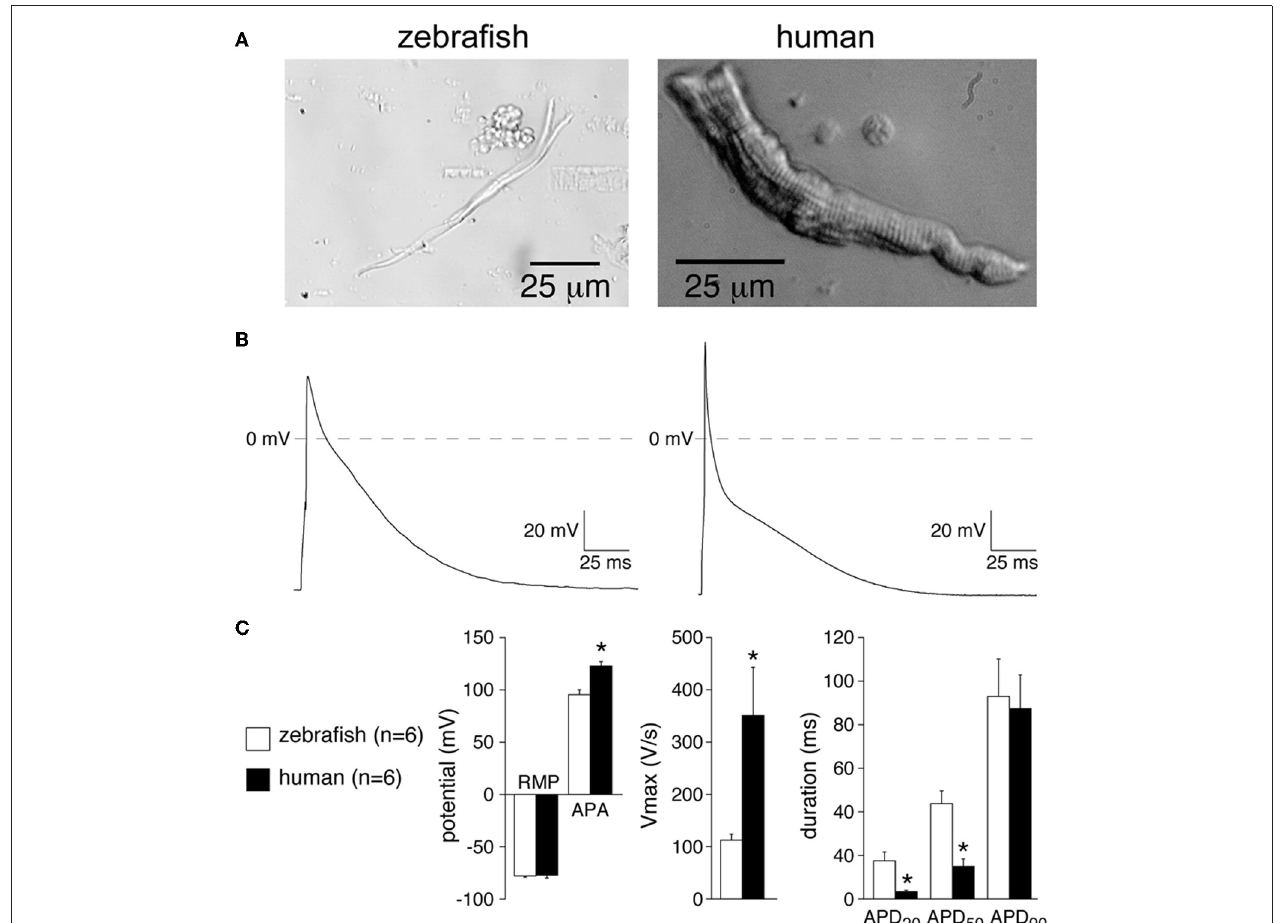
(zebrafish) and Verkerk et al., 2007 (human) for solutions used]. (C) Average AP characteristics of zebrafish and human atrial myocyte recorded at 1Hz. RMP, resting membrane potential; APA, AP amplitude; Vmax, maximal AP upstroke velocity; APD 20 , APD 50 , and APD 90 , AP duration at 20, 50, and 90% repolarization, respectively. Values are mean ± SEM; ∗ P < 0 . 05 ( t